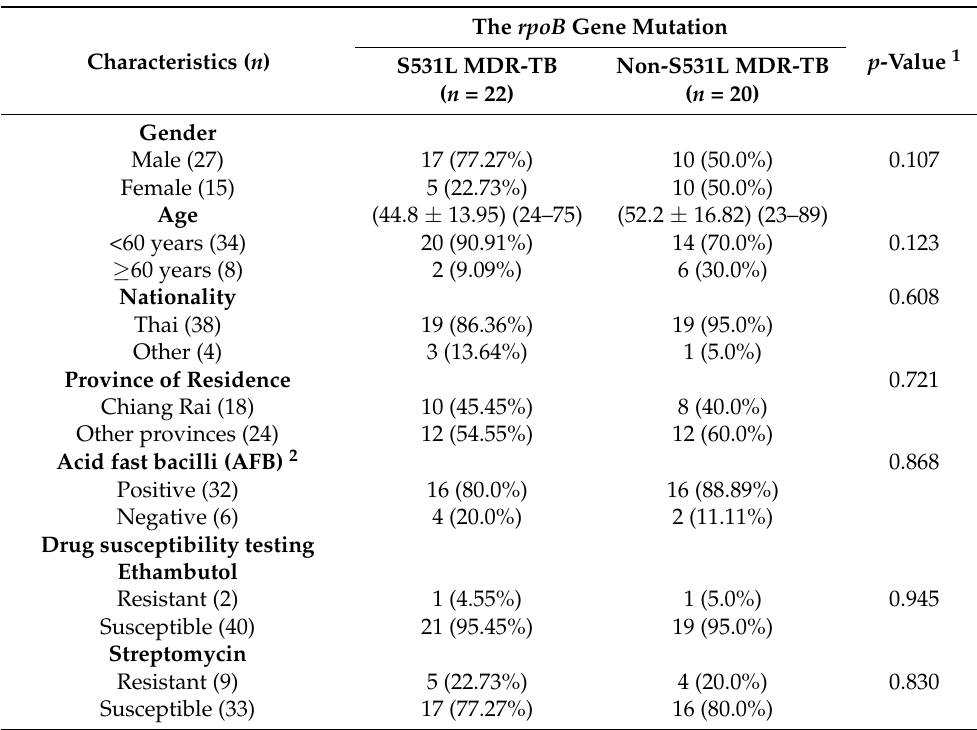
Table 4. Demographics and clinical characteristics of MDR-TB patients with different rpoB gene mutations (S531L MDR-TB vs. non-S531L MDR-TB).